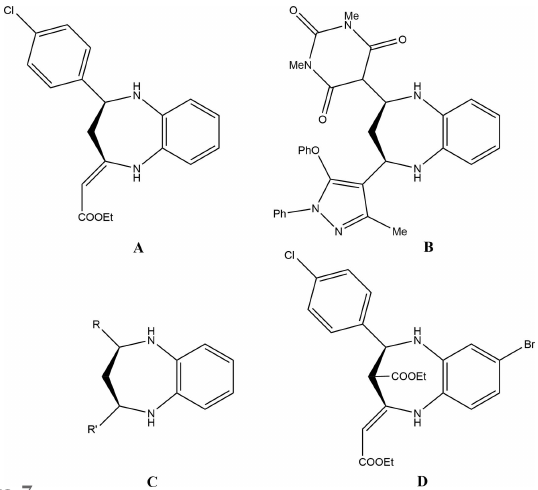
Figure 7 Diagrams of compounds structurally related to